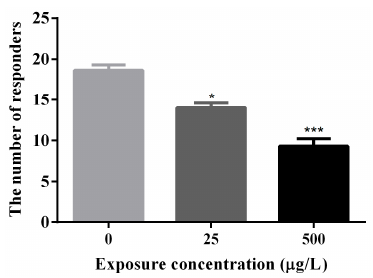
Figure 3. Locomotor behavior of methamidophos-exposed zebrafish larvae at 72 hpf. * p < 0.05; *** p < 0.001.